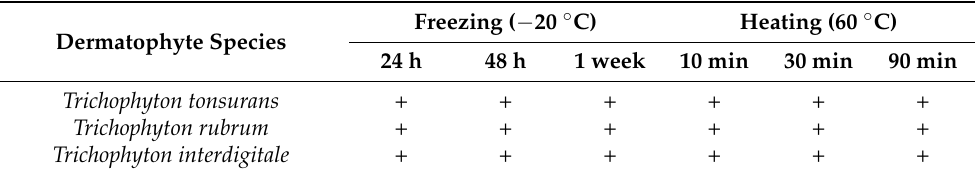
Table 2. Viability of cells/conidia of three Trichophyton species on previously contaminated gauze pads after freezing and direct heat exposure at diverse temperatures and times. Dermatophyte